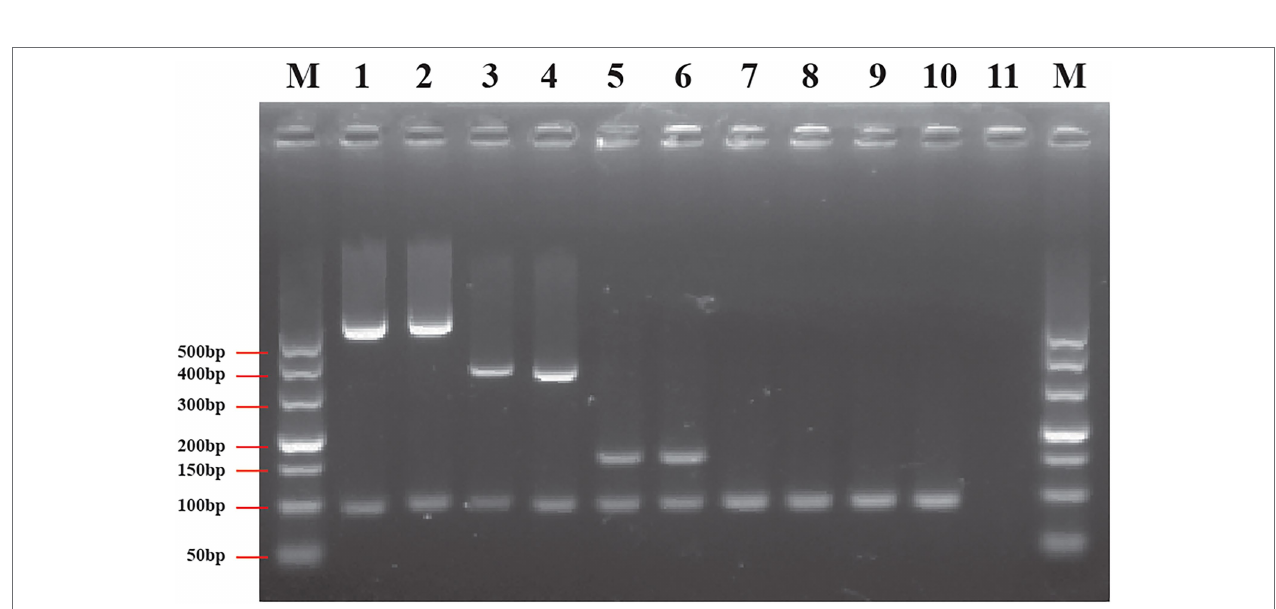
FIGURE 5 | Results of multiplex PCR based on genus- and species-specific genes. Lane M: DNA marker; lane 1: Cronobacter sakazakii ATCC 29544 ™ ; lane 2: C. sakazakii ATCC BAA-894 ™ ; lane 3: Cronobacter malonaticus LC03; lane 4: C. malonaticus LC07; lane 5: Cronobacter turicensis LC08; lane 6: C. turicensis LC12; lane 7: Cronobacter dubliniensis LC01; lane 8: C. dubliniensis LC02; lane 9: Cronobacter universalis LC09; lane 10: C. universalis LC10; and lane 11: negative control without